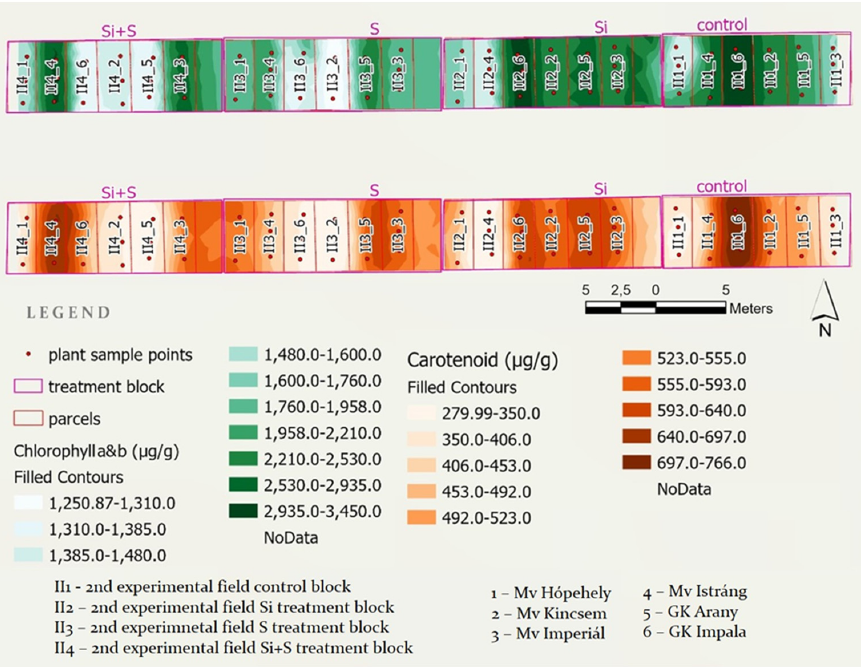
Figure 10. Chlorophyll a and b and carotenoid content spatial distribution maps generated in ArcGIS Pro from point sample laboratory measurements.